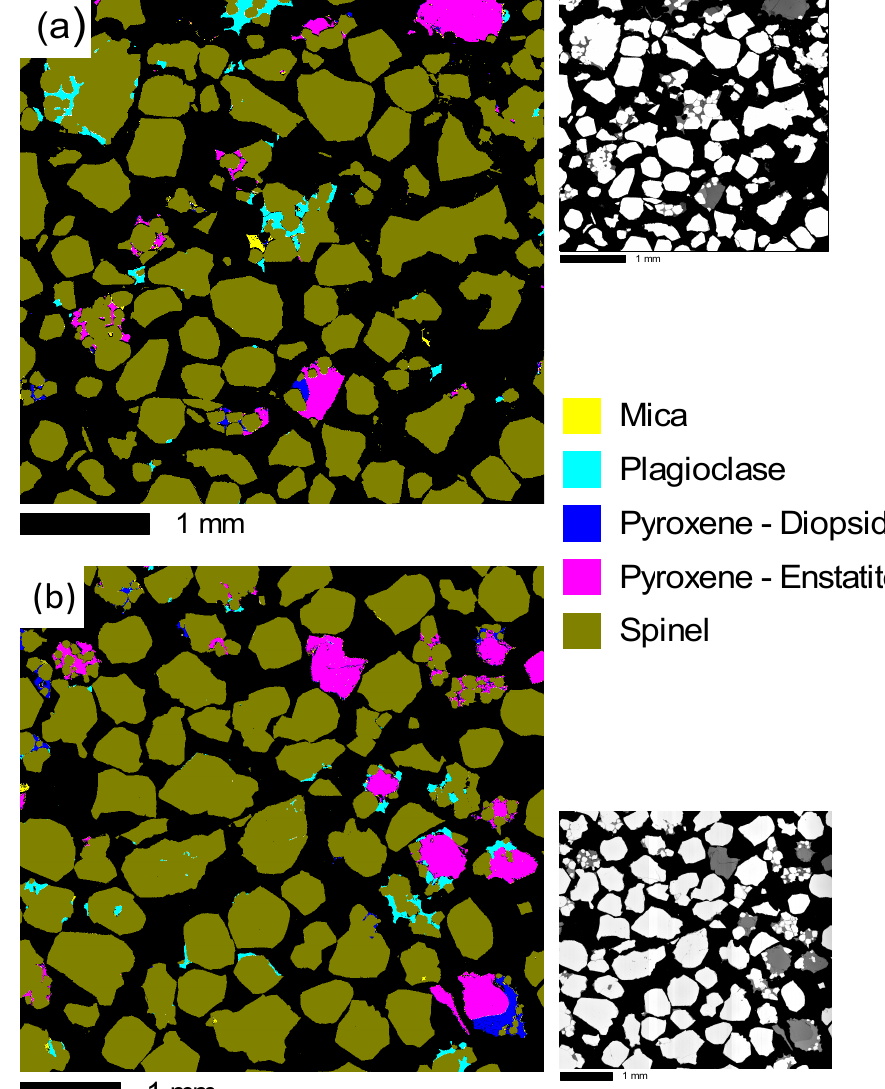
Figure 4. Phase-patched maps for ( a ) the − 2 mm bulk sample and ( b ) the − 600 +425 μ m fraction. The BSE image for each of the mapped areas was included for comparison purposes.